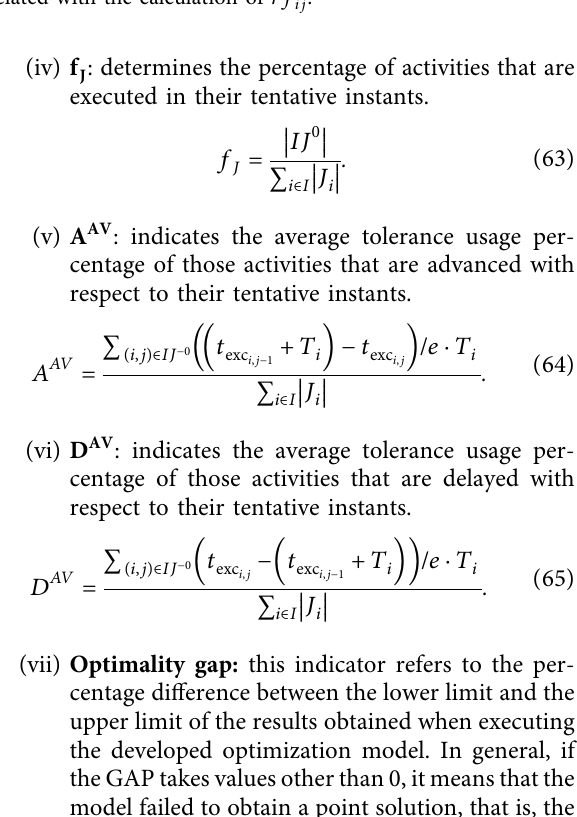
Figure 5: Operation of the constraints associated with the calculation of rf